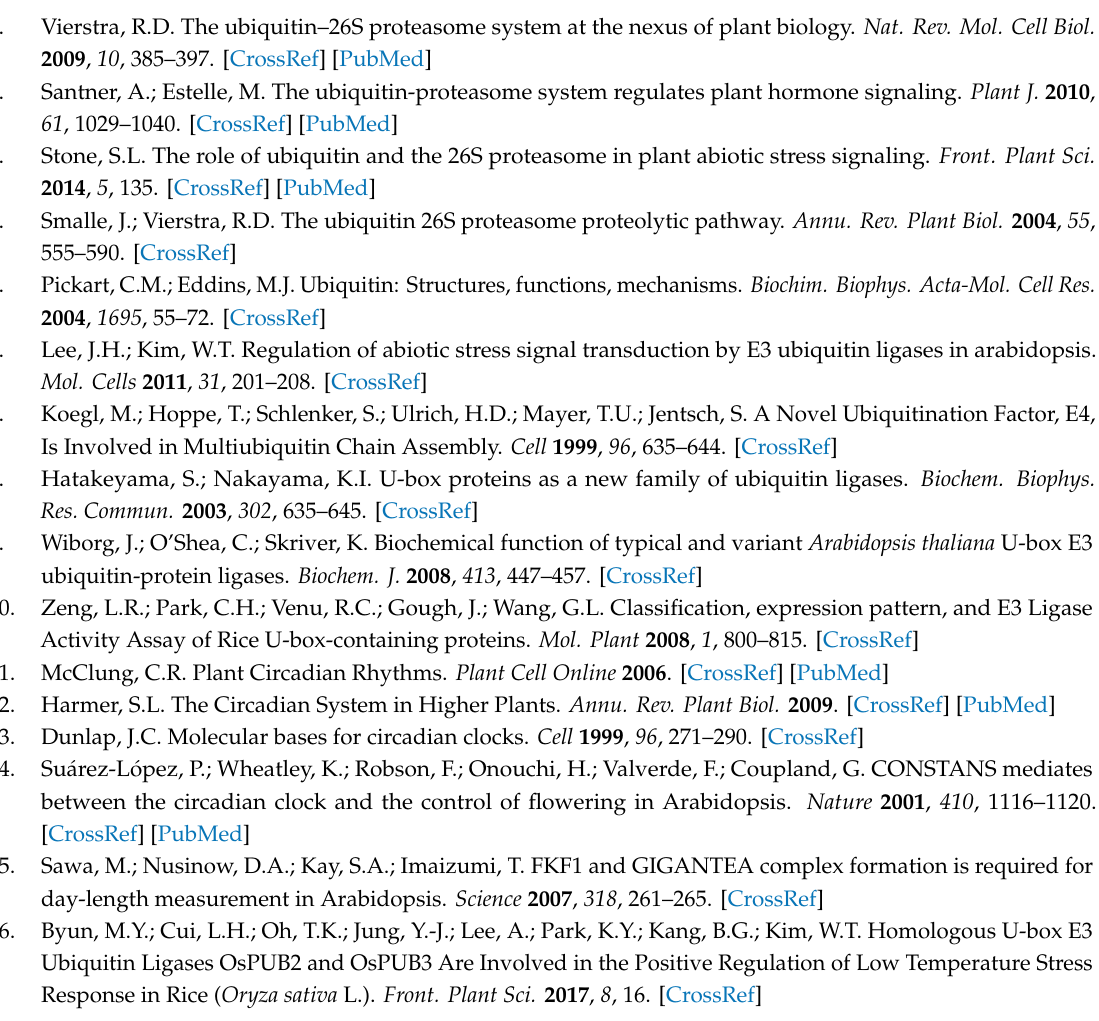
Figure S1: Heat-map expression data associated with the diurnal rhythm of the OsPUB family genes. Figure S2: Diurnal expression patterns of OsPUB2 gene evaluated at 12 time points over 24-h period in “Dongjin” rice and osgi mutant. Table S1: Summary of primer sequences used for qRT-PCR analyses of this